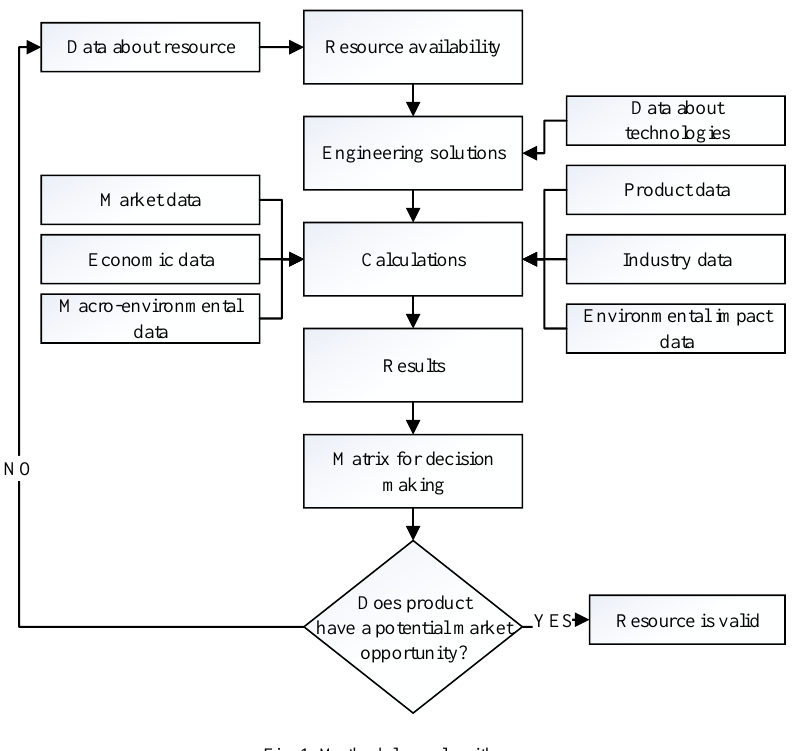
Fig. 1. Methodology